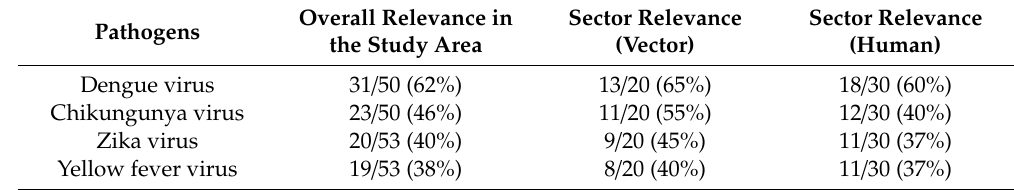
Table 3. Non-zoonotic pathogens perceived relevance in the study area and by